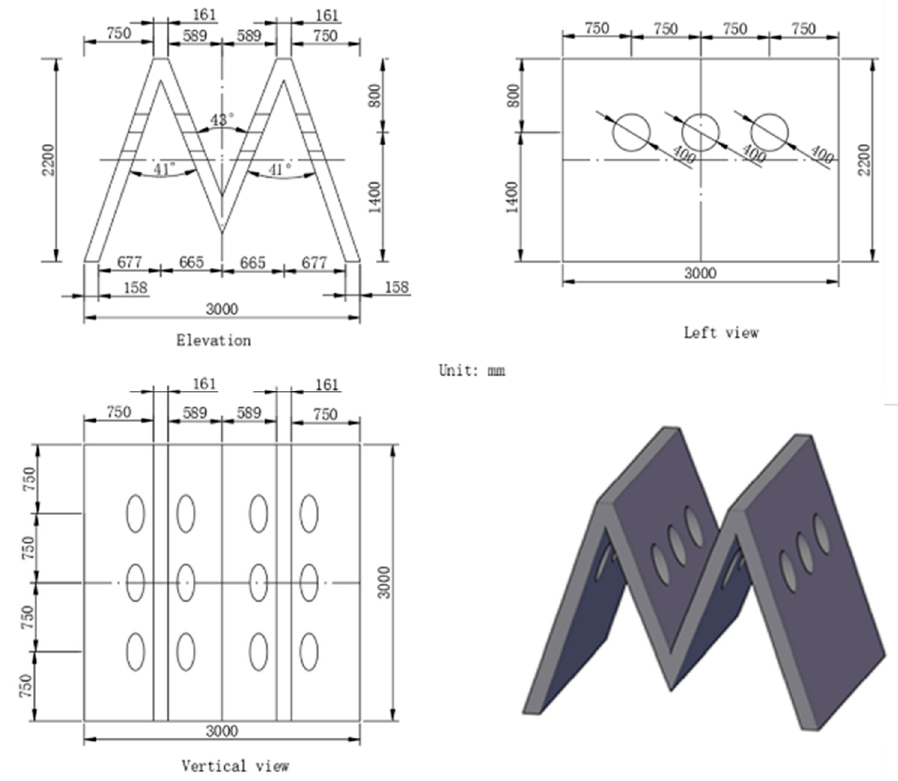
Figure 2. Three views and schematic diagram of M-shaped artificial reef